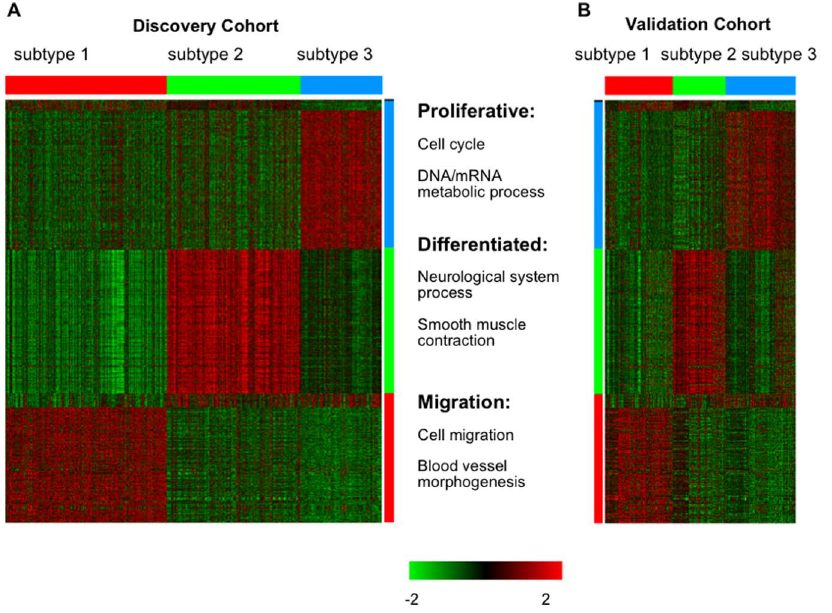
Figure 2. Identification and validation of three CRC subtypes based on gene expression data. (A) Using the 1472 selected genes, 985 core samples in the discovery cohort were clustered into three subtypes. For each subtype, samples and signature genes were labeled with same color (red bar for subtype 1, green bar for subtype 2 and blue bar for subtype 3). Biological processes enriched with signature genes for each subtype are shown beside the color bars; (B) Using the same ordering of signature genes and CRC subtypes as (A), the gene expression pattern for the 485 CRC samples from the validation cohort was shown.